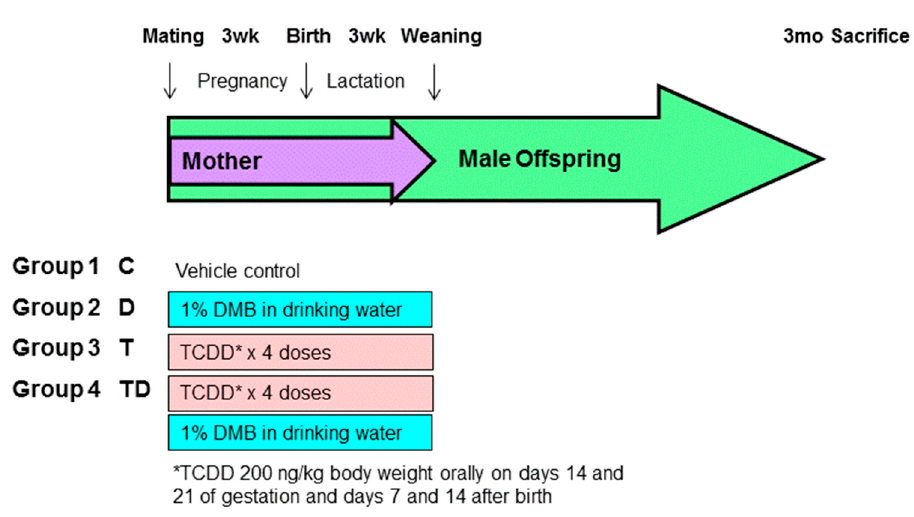
Figure 1. Experimental protocol used in the present study. *TCDD 200ng/kg body weight orally on days 14 and 21 of gestation and days 7 and 14 after birth.